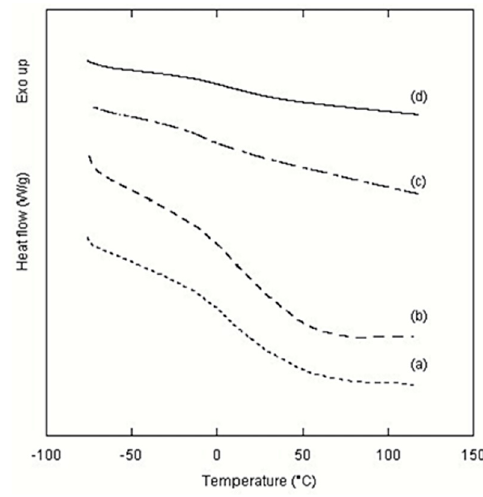
Figure 4. DSC curves for bio-PU made with bio-polyol 1 and ( a ) 1 mol %; ( b ) 2 mol %; ( c ) 3 mol % and ( d ) 5 mol % catalysts MoCl 2 O 2 .